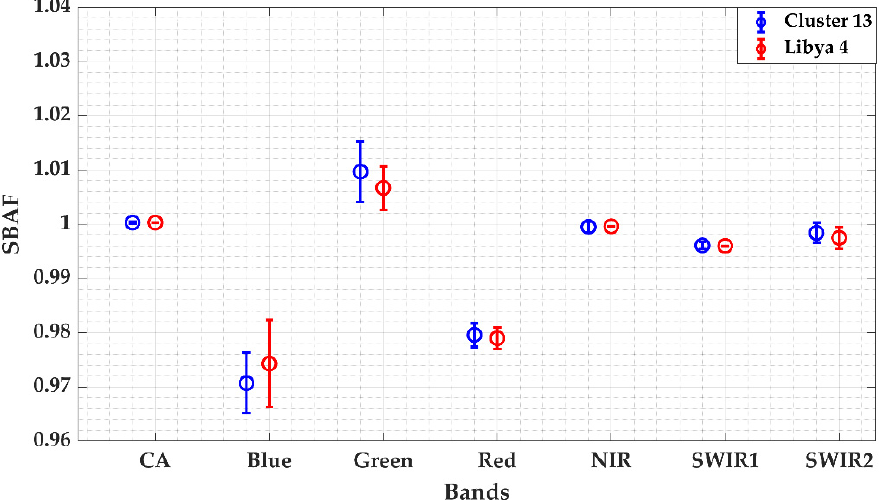
Figure 17. Spectral Band Adjustment Factor (SBAF) for Sentinel 2A MSI for Libya 4 ROI and Cluster 13 (error bars represent the standard deviation, k = 2).